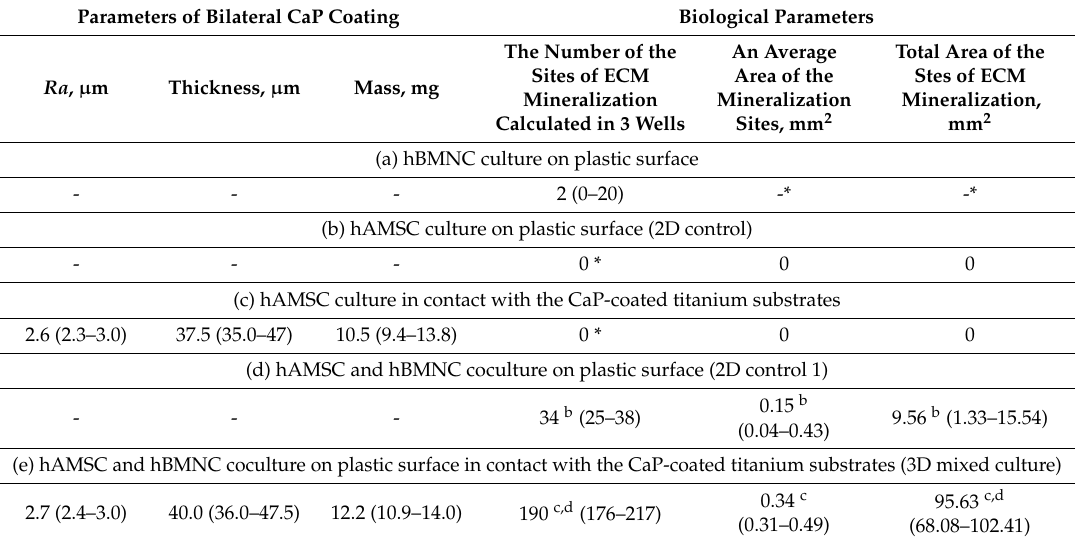
Table 2. In vitro hAMSC and hBMNC osteogenic di ff erentiation with ECM mineralization after 21 days of culture, Me (Q1–Q3), n =